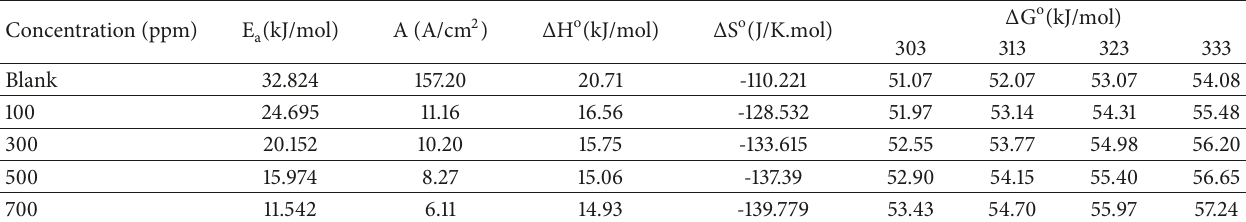
Table 6: Thermodynamic parameters for corrosion of brass in 1M HCl with